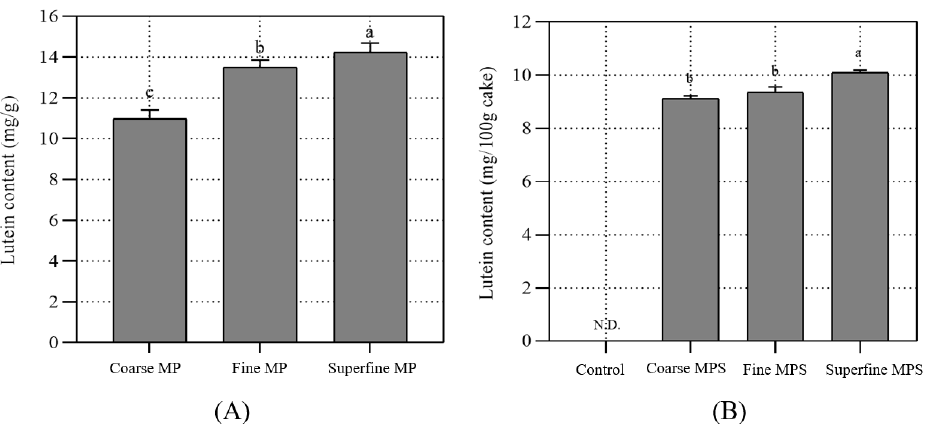
Figure 4. Lutein content of sponge cakes prepared with differently sized MP. ( A ) Lutein content of MP, ( B ) lutein content of sponge cake. Values with different letters within the same column (a–c) are significantly different ( p < 0.05) according to the results of Duncan’s test. Coarse MP: coarse